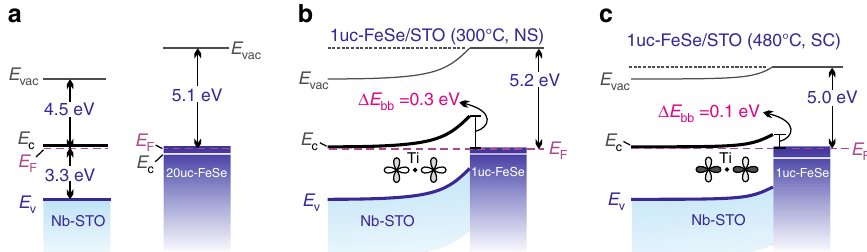
Fig. 4 Band alignment of FeSe and SrTiO 3 . a Energy bands of Nb-doped STO and 20uc-FeSe separately. b , c Energy band pro fi le across the FeSe/STO heterostructure at the NS and SC stages, respectively. The double fi gure-of-eight patterns represent the O 2 p orbitals. Dark color highlights the